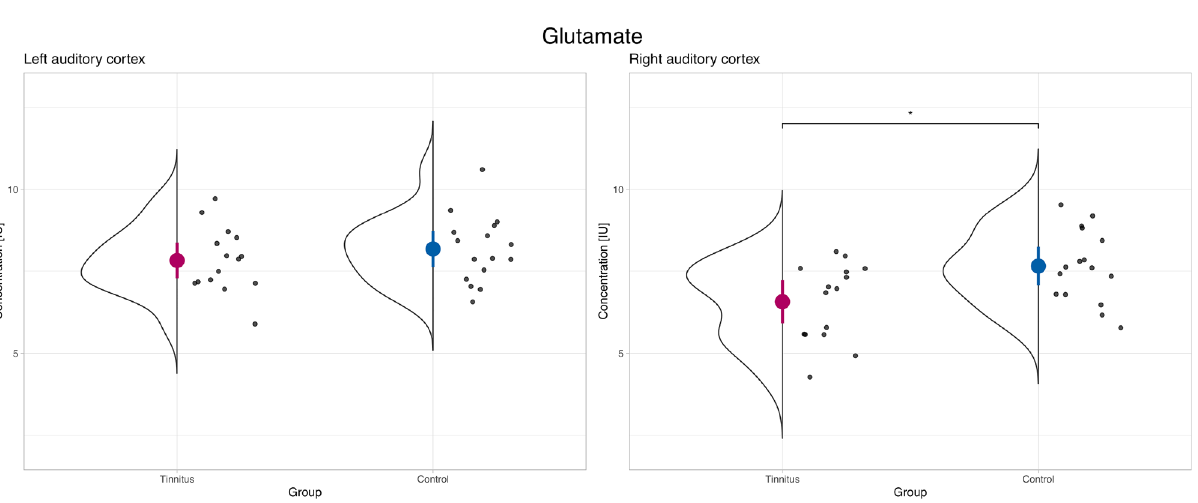
Figure 4. Glu concentration levels in left and right auditory cortex. The colored dot denotes the sample mean. The error bar covers the lower and upper Gaussian confidence limits based on the t -distribution. IU institutional